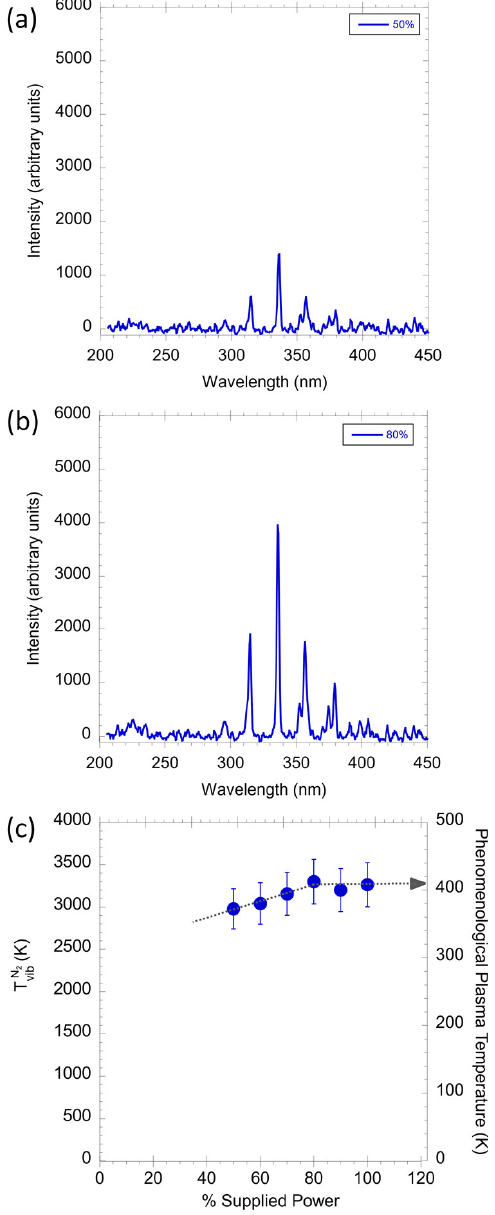
Figure 8. The emission spectra recorded at ( a ) 50% and ( b ) 80% of the maximum supplied power; ( c ) the T N 2 and the PPT of excited N 2 species as a function of the supplied power. vib The values of on the T N 2 and the PPT versus the air flow velocity, recorded at x and y vib of 0 and 25 µ m, were investigated. Figure 9 shows the T N 2 as a function of the air velocity vib from 0 to 1.6 m · s − 1 . As shown in the figure, there is no significant correlation between the T N 2 and the velocity of the air flow. The T N 2 values, recorded at x and y of 0 and 25 µ m, vib vib are maintained at approximately 3000 K under different air flow conditions. Therefore, the effect of air flow velocity on T N 2 and PPT can be vib